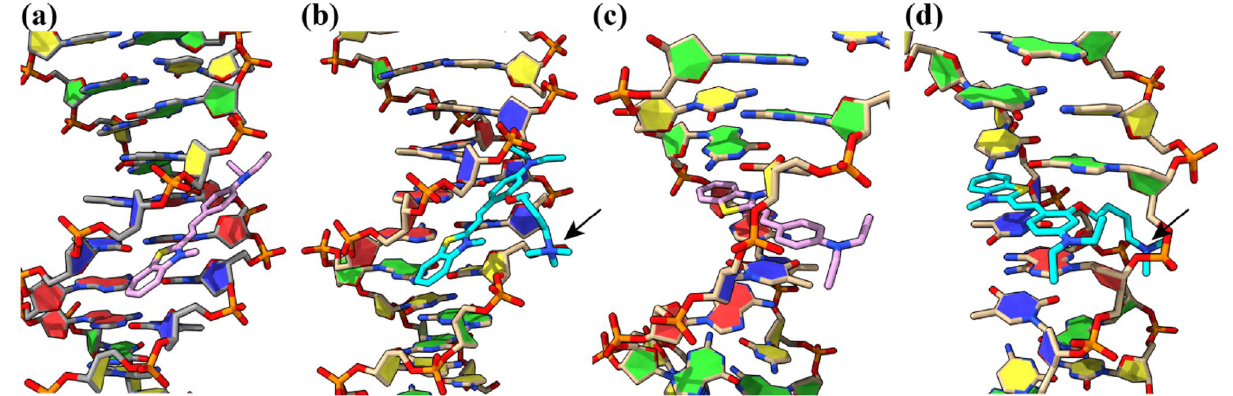
Figure 4. Molecular docking of ( a ) BT + , ( b ) BT2 + (NEt 2 ) on a minor-groove DNA (4C64) and ( c ) BT + , ( d ) BT2 + (NEt 2 ) at an intercalative site of DNA (108D). Black arrows indicate the electrostatic interaction of quaternary ammonium side chain to the phosphate